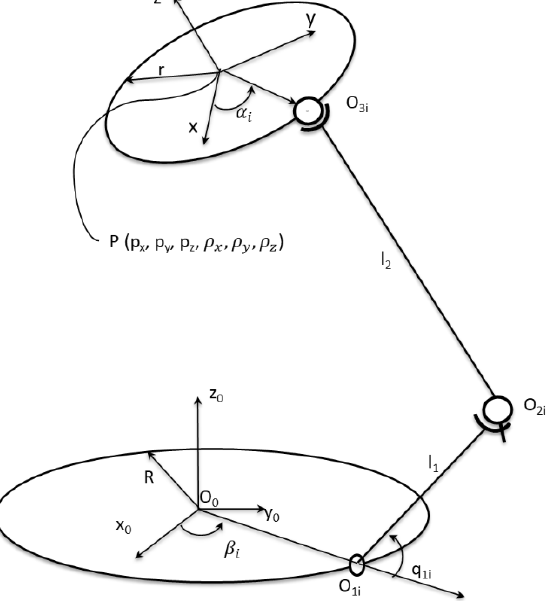
Figure 5. Parallel robot (only one RUS open loop is